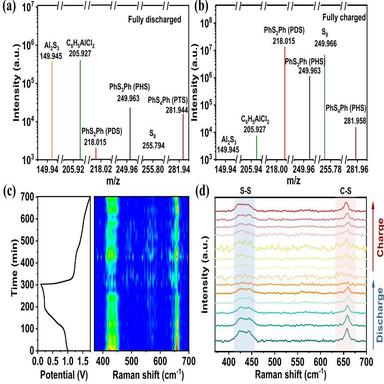
(a, b) QTof-MS results of the PTS electrode at the full discharge (a) and full charge (b) states in the first cycle. (c) In situ Raman spectra of PTS during the first cycle. (d) Representative Raman spectra profiles in (c).